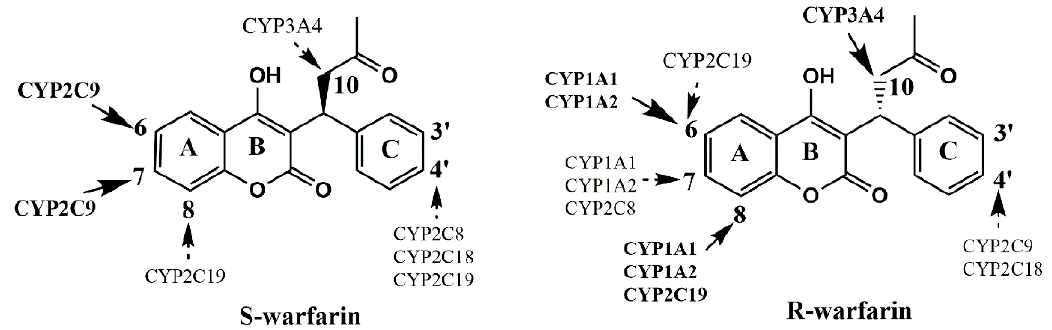
Figure 1. Sites of hydroxylation of R- and S-warfarin catalyzed by human P450s to form hydroxy- warfarins.